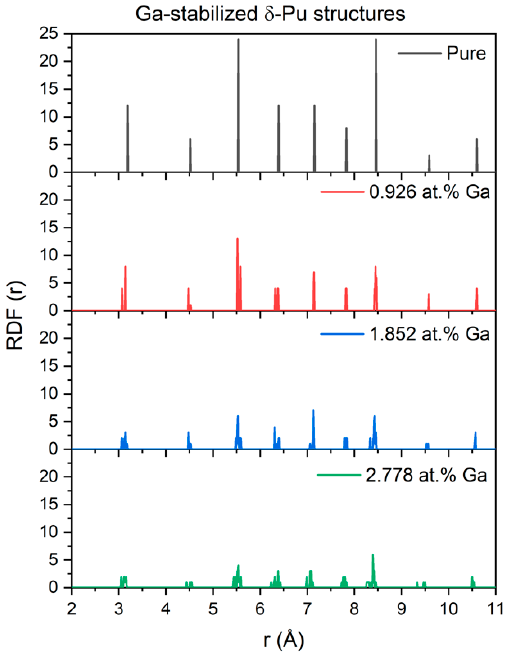
Figure 3. Radial distribution functions (RDF) for 0 (pure), 0.926, 1.852, and 2.778 at. % Ga δ -Pu structures from the perspective of the Ga atom when applicable. Nearest neighboring shells include first, second, third, fourth, fifth, sixth, seventh, ninth, and tenth.